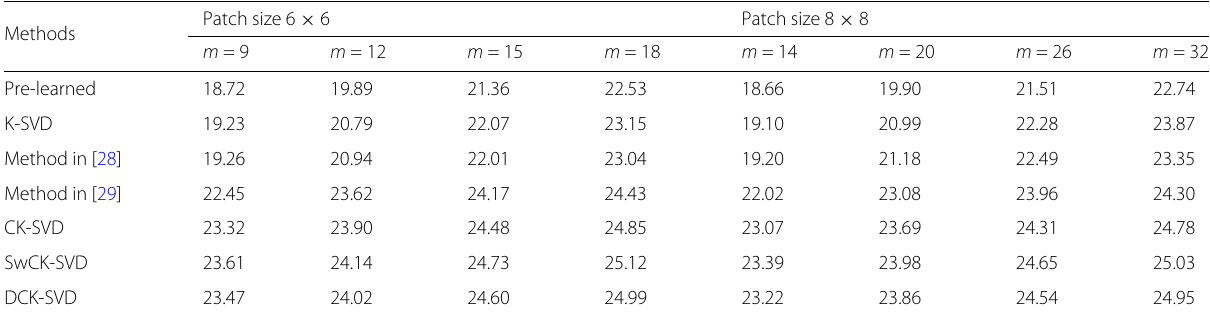
Table 6 Comparison of PSNR (dB) of reconstructed image “Horse” using the pre-learned dictionaries for initialization Patch size 6 × 6 Methods